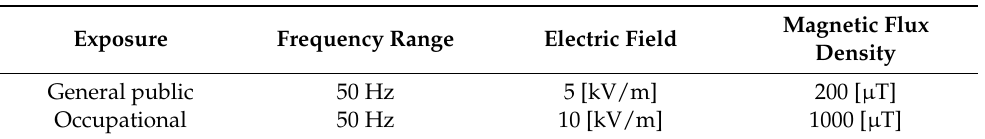
Table 1. Reference levels for the general public and occupational exposure to the time-varying electric field and magnetic flux density